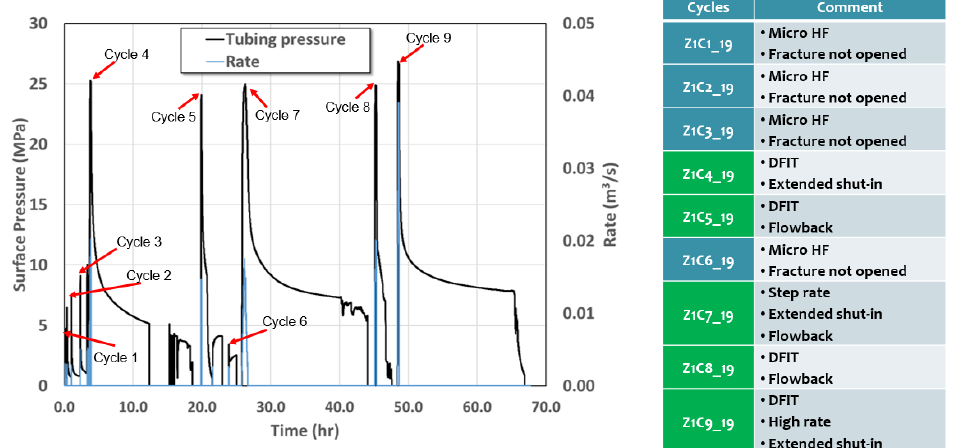
Figure 6. Pressure-rate relationships during the 2019 injection testing of Zone 1 (Z1) during Cycles 1–9 (C1–9). The cycle designation indicates the zone, the cycle number, and the year the measurements were made. See Figure 5 for abbreviations.